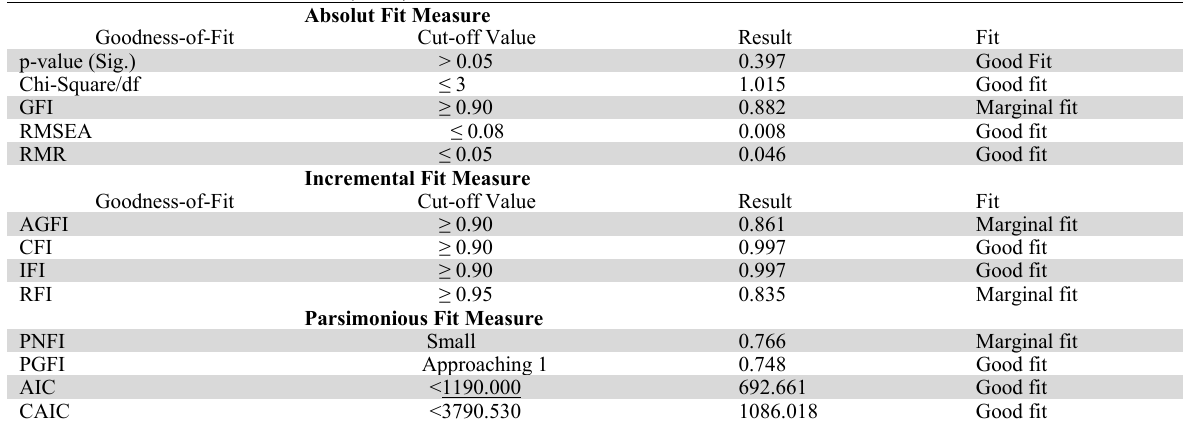
Table 7 Goodness of Fit Test of Full Model (SEM)